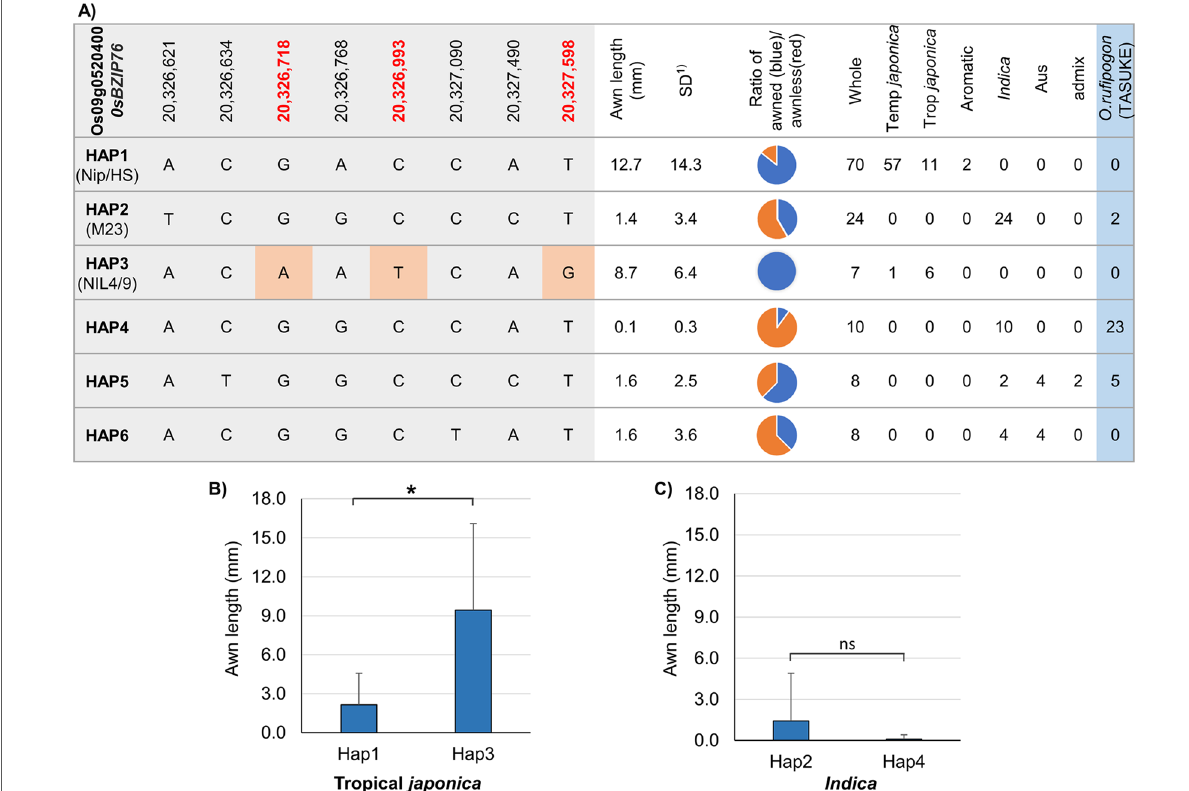
Fig. 6 Variations in Os bZIP76 were significantly associated with awn development. Haplotype analysis of Os bZIP76 for awn length ( A ). Comparison of awn lengths in different haplotypes in tropical japonica ( B ) or indica ( C ). * and ns significant at p < 0.05 and not significant, respectively ( t ‑test). 1) SD standard